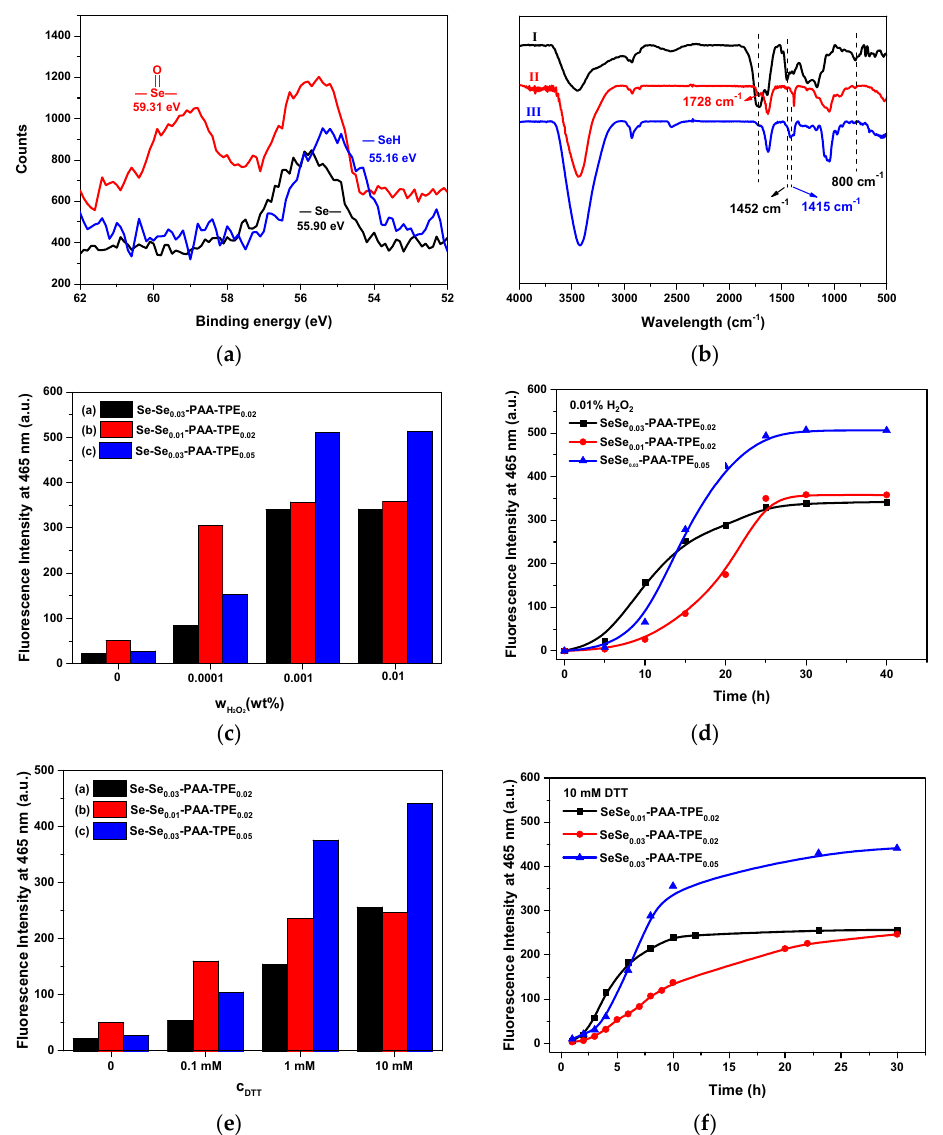
Figure 2. ( a ) X-ray photoelectron spectroscopy (XPS) data of SeSe 0.03 -PAA-TPE 0.02 before and after oxidation by 0.01 wt.% H 2 O 2 and reduction by 10 mM dithiothreitol (DTT) for 24 h; ( b ) Fourier transform infrared spectroscopy (FT-IR) spectra of SeSe 0.03 -PAA-TPE 0.02 before (I) and after the reactions with 0.01 wt.% H 2 O 2 (II) and 10 mM DTT (III); ( c , e ) fluorescence intensities at 465 nm in solution after SeSe 0.03 -PAA-TPE 0.02 (black), SeSe 0.01 -PAA-TPE 0.02 (red), SeSe 0.03 -PAA-TPE 0.05 (blue) reacted with different ( c ) H 2 O 2 or ( e ) DTT concentrations; ( d , f ) changes in fluorescence intensities at 465 nm in solution for SeSe 0.03 -PAA-TPE 0.02 (black), SeSe 0.01 -PAA-TPE 0.02 (red), and SeSe 0.03 -PAA-TPE 0.05 (blue) in response to ( d ) 0.01 wt.% H 2 O 2 or ( f ) 10 mM DTT ( λ Ex = 340 nm, slit width for excitation (Ex.) and emission (Em.) = 5.0, photomultiplier tubes voltage (PMT) = 400V).